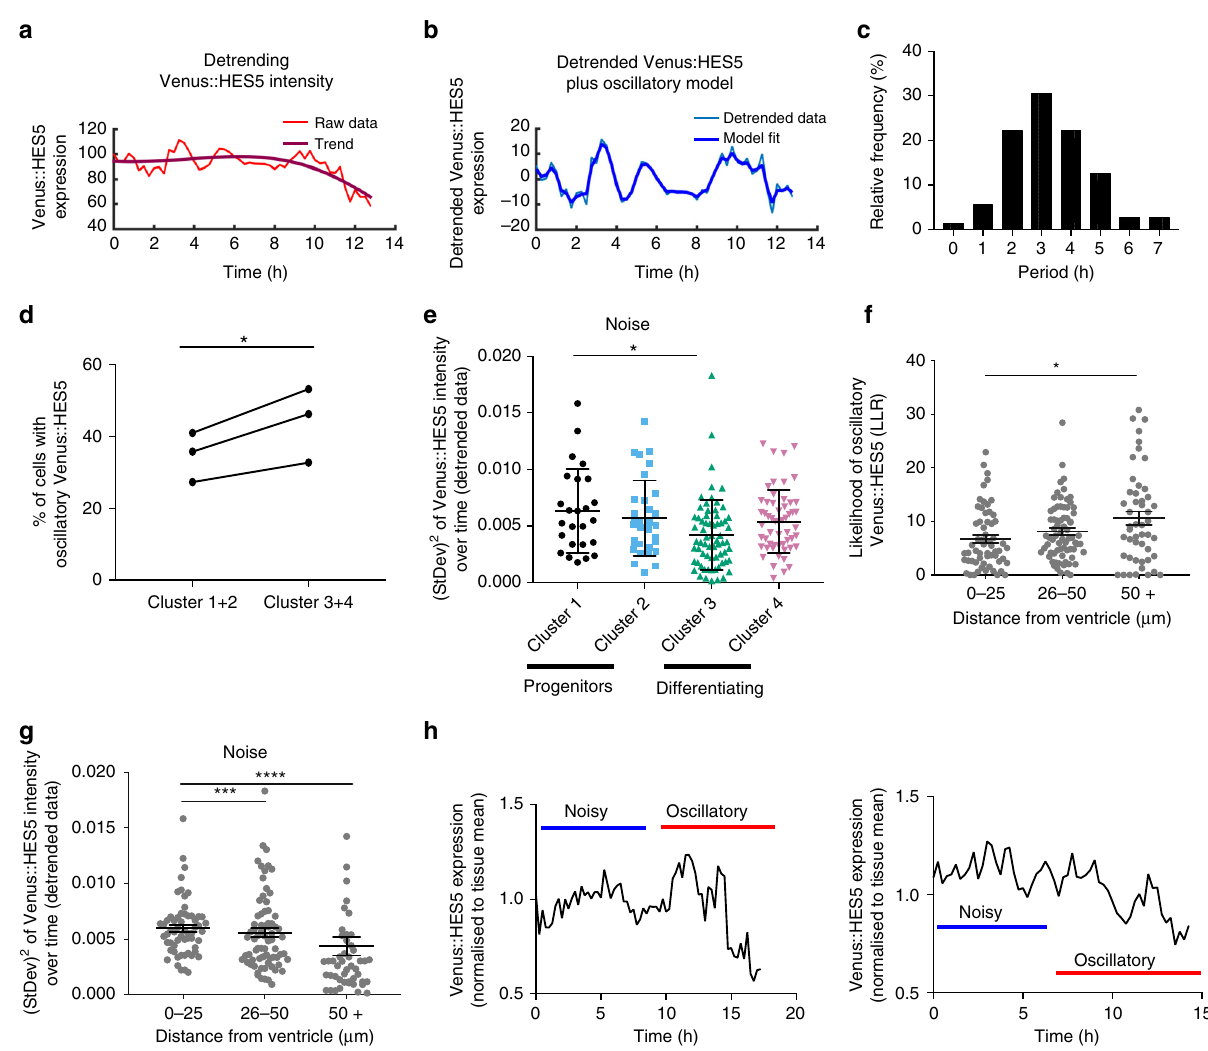
Fig. 5 Differentiating cells are oscillatory and progenitors are noisy. Example single-cell traces of Venus::HES5 expression subject to oscillatory test. a Raw single-cell Venus::HES5 intensity timeseries with overlaid long-term trend in bold. b Detrended single-cell Venus::HES5 intensity timeseries with overlaid OUOsc oscillatory model in bold. c Single-cell periods of Venus::HES5 protein dynamics from oscillatory cells. Mean = 3.3 h, SD = 1.4 h. n = 72 cells, three experiments. d Percentage of single cells classi fi ed as having oscillatory Venus::HES5 protein expression in cluster 1 + 2 vs. cluster 3 + 4. n = 3 experiments, p -value = 0.04 (*) in Wilcoxon paired test, two-tailed. Single-cell raw Venus intensity was detrended and subject to oscillatory test (see the section “ Methods ” ). e Noise in single cell Venus::HES5 expression dynamics per cluster as measured by the squared standard deviation of de-trended Venus:: HES5 signal over time. Lines show mean, error bars — SD. Kruskal – Wallis with Dunn ’ s multiple comparison test shows cluster 1 vs. 3 adjusted p = 0.04 (*). 181 cells, three experiments clustered separately. Cluster 1 — black ( n = 27 cells), cluster 2 — sky blue (n = 33 cells), cluster 3 — green ( n = 67 cells), cluster 4 — pink ( n = 54 cells). f Likelihood of a cell having oscillatory Venus::HES5 expression indicated by LLR score plotted by average distance of the cell away from the ventricle over 12-h track. Bars show mean and error bars show SEM. Kruskal – Wallis with Dunn ’ s multiple comparison test shows 0 – 25 μ m vs. 50 + μ m adjusted p = 0.03 (*). g Noise in single cell Venus::HES5 expression dynamics plotted by average distance of the cell away from the ventricle over 12-h track. Bars show mean and error bars show SEM. Kruskal – Wallis with Dunn ’ s multiple comparison test shows 0 – 25 μ m vs. 26 – 50 adjusted p = 0.0007 (***) and 0 – 25 μ m vs. 50 + μ m adjusted p = <0.0001 (****). h Example single-cell timeseries of relative Venus::HES5 protein expression in ex vivo live E10.5 Venus::HES5 spinal cord slice cultures showing noisy to oscillatory transition in Venus::HES5 dynamics. Source data are provided in a Source Data fi